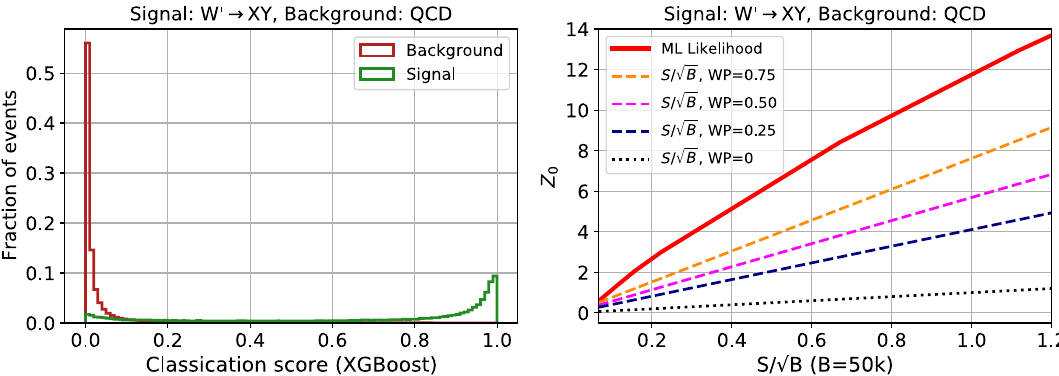
Fig. 8 Left panel: classification score for the BSM search of W (cid:2) using a XGBoost binary classifier. Independent pure signal and pure back- ground test samples are evaluated to estimate p s , b ( x ) . Right panel: sig- nificance calculated with several methods as a function of the signal-to- background ratio for (cid:8) B (cid:9) = 50k and (cid:8) S (cid:9) within [ 10 , 300 ] . Same color